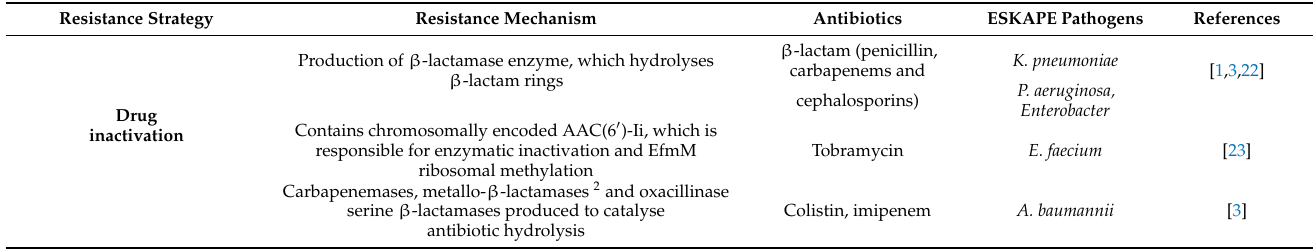
Table 1. Resistance strategies used by ESKAPE pathogens to escape